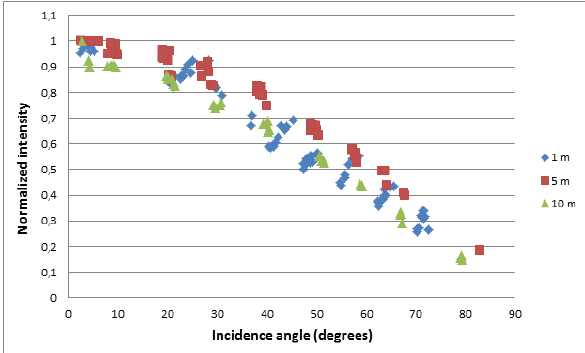
Figure 8. Comparison of the incidence angle effect of the 99 % reflectance Spectralon panel when distance effect has been corrected from the intensity data. Distances of 1, 5 and 10 meters are compared. The intensity is normalized to 1 at 0